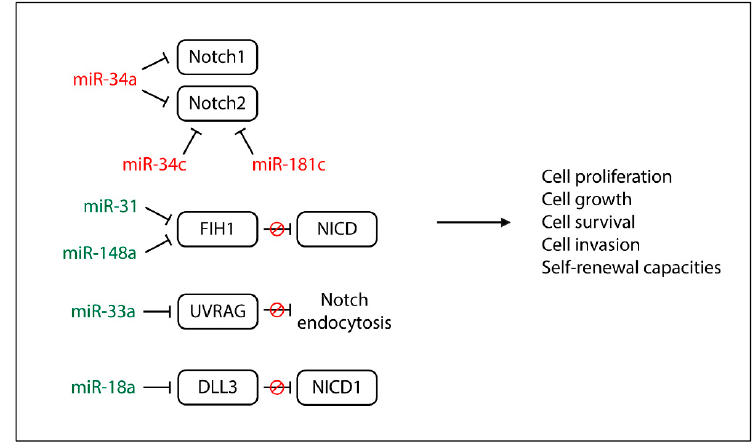
Figure 3. Functional effects of Notch-regulated miRNAs in glioblastoma multiforme (GBM). Red miRNAs are downregulated while the green ones are upregulated in GBM cells.